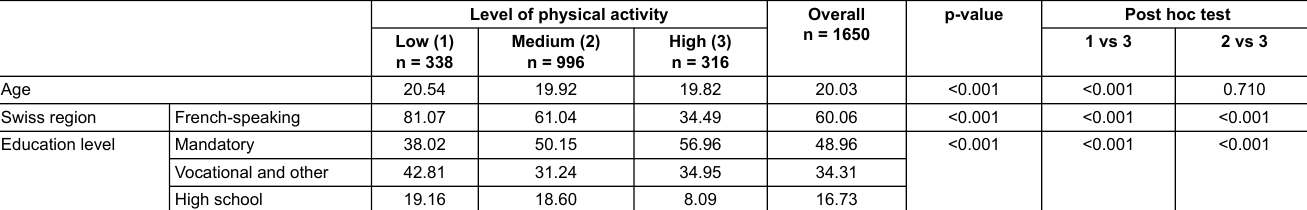
Table 1: Socio-demographic characteristics of the respondents belonging to the low, medium and high physical activity groups.